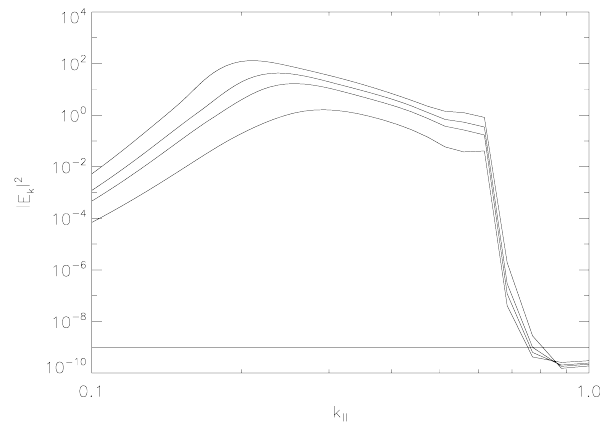
Fig. 1. Spectral density of the lower hybrid waves as function of the parallel wave number for S1 set of parameters at times t = ( 0 ; 7 . 7 × 10 2 ; 9 × 10 2 ; 9 . 7 × 10 2 ; 1 . 1 × 10 3 ) 1 ber is measured in ω ce (cid:14) v T, c .